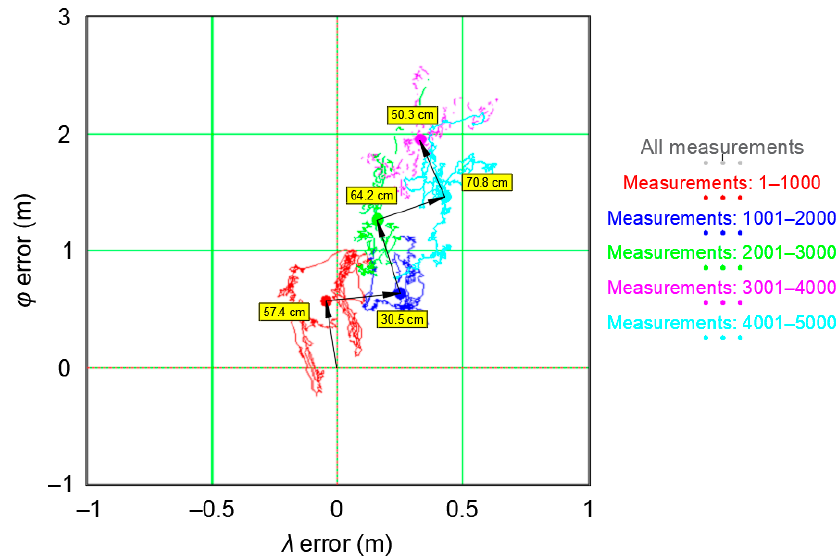
( ) P S calculated for five GPS sessions during N